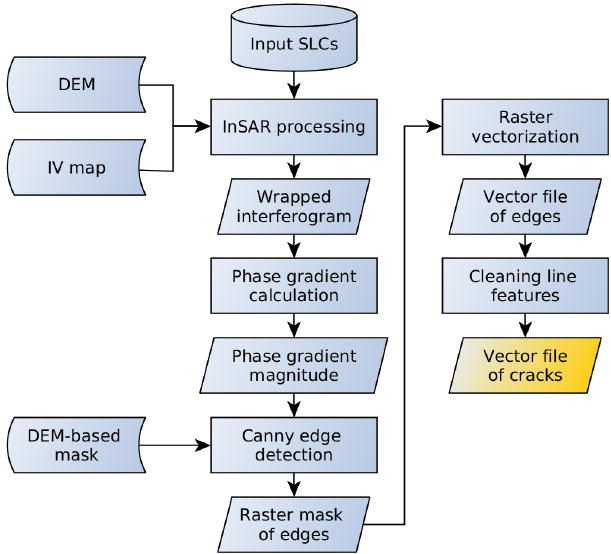
Figure 3. Processing line for automatic delineation of cracks with